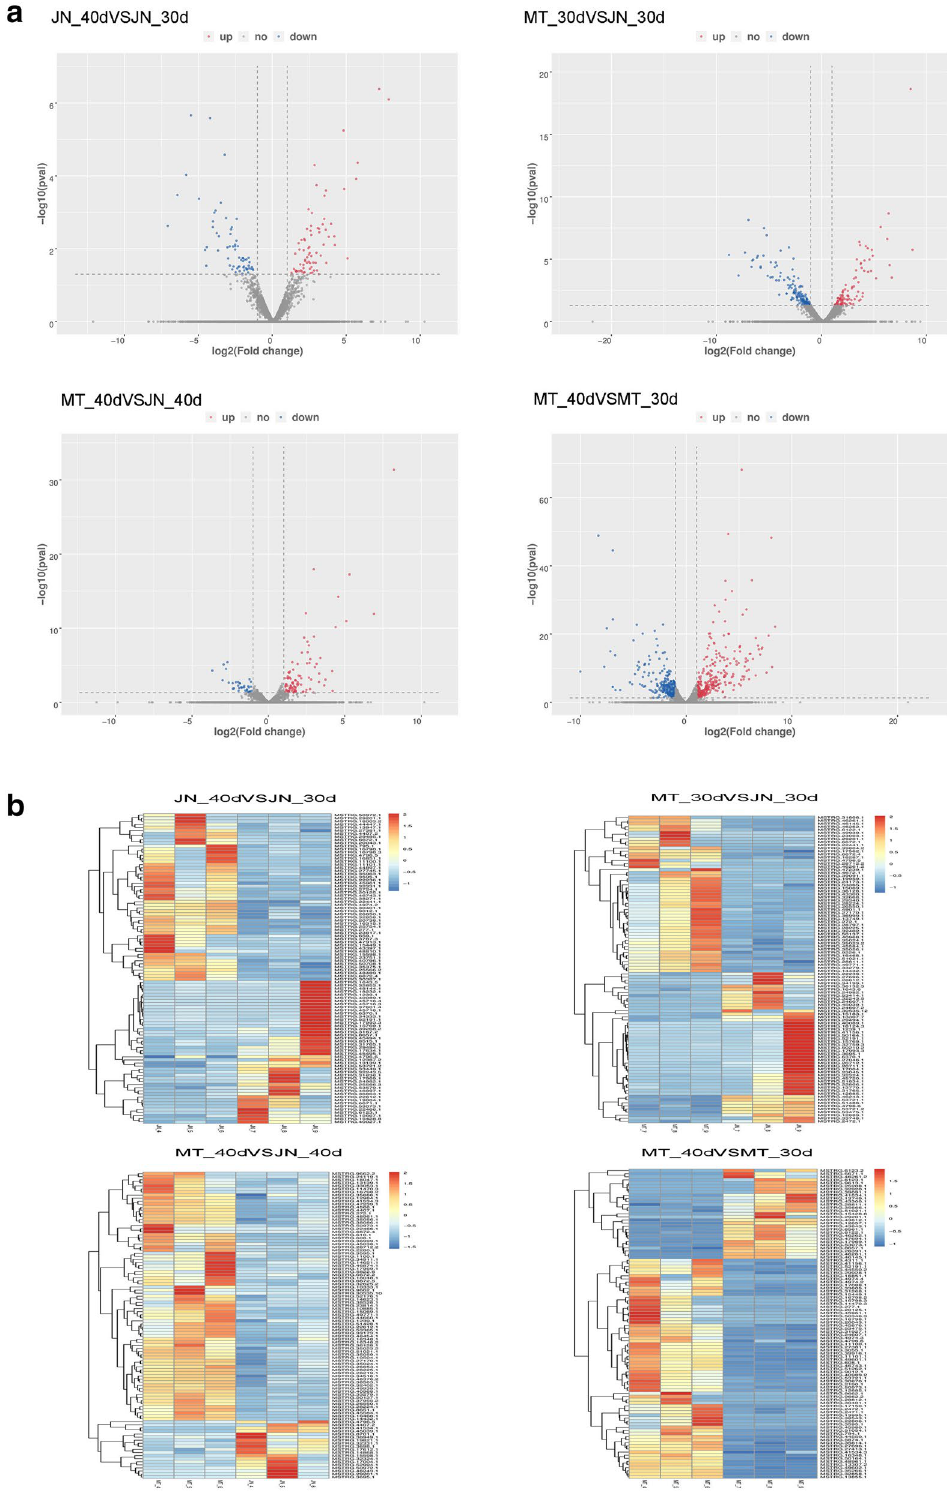
Figure 7. Differentially expressed lncRNAs in soybean. ( a ) Significantly up-regulated (red dots) and down- regulated (blue dots) lncRNAs. ( b ) Clustering of 561 differentially expressed lncRNAs in soybean. The ( b ) in Fig. 6 is made from the open software pheatmap (v1.0.12, https:// cran.r- proje ct. org/ web/ packa ges/ pheat